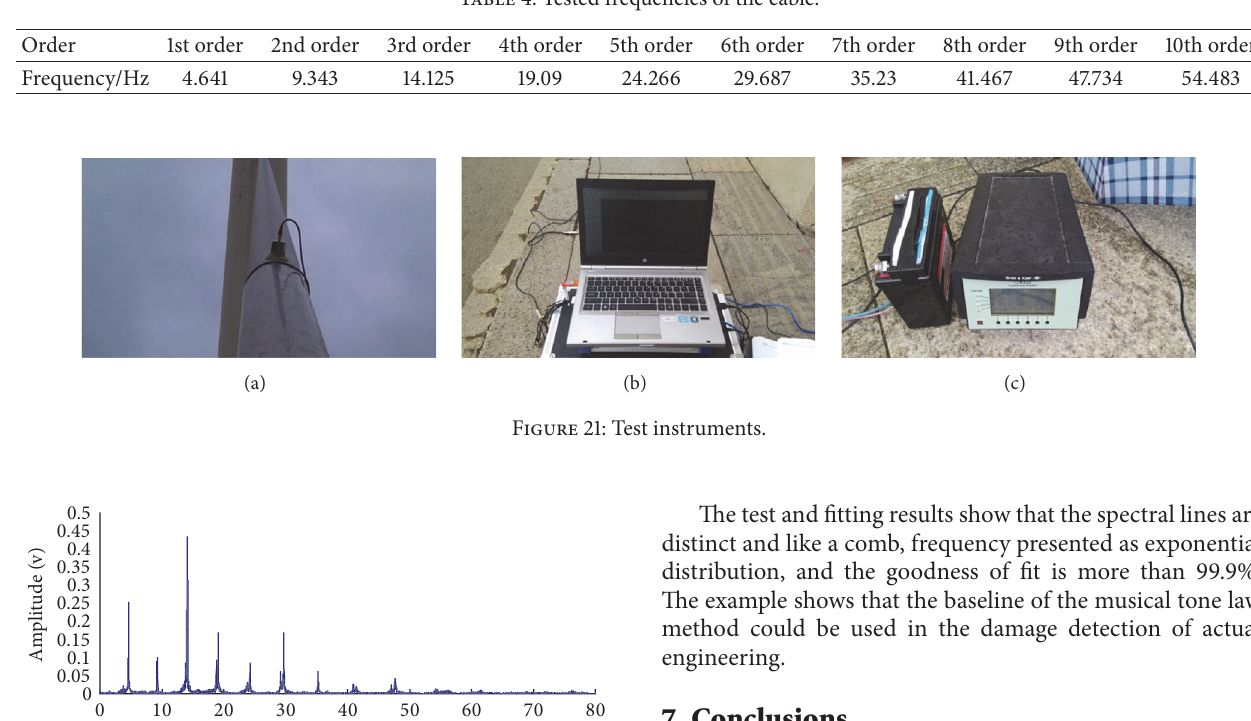
frequency value is shown in Figure 23. The fitting function and goodness is shown in 𝑦 = 87.71𝑒 0.048𝑥 −